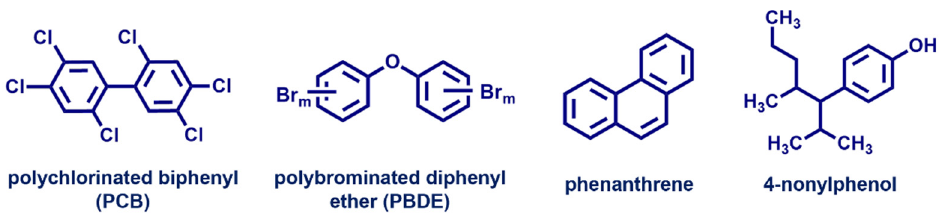
Figure 14. Chemical structures of typical polychlorinated biphenyl, polybrominated diphenyl ether, polycyclic aromatic hydrocarbon (phenanthrene) and alkylphenol.